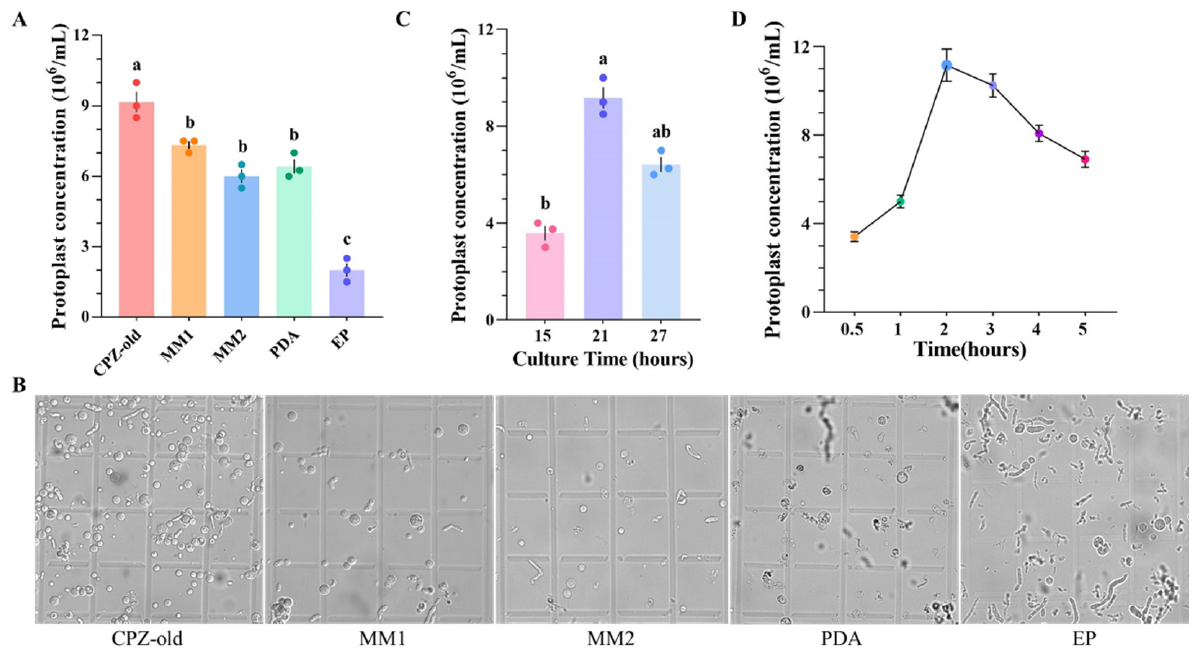
Figure 3. Optimization of protoplast production from A. niger N1 for protoplast-mediated trans- formation (PMT). ( A ) Column diagram of the numbers of protoplast production from A. niger N1 in different media (CPZ-old, MM1, MM2, PDA, and EP). ( B ) The protoplast production in each 4 × 4 square corner area of the hemocytometer for A. niger N1 in different media (CPZ-old, MM1, MM2, PDA, and EP). ( C ) Protoplast production at different culture times (15, 21, and 27 h) of A. niger N1 in CPZ-old medium. ( D ) Protoplast production with different lysing times (0.5, 1, 2, 3, 4, and 5h) of A. niger N1 cultured on CPZ-old medium. Data represent mean ± SD. Means with different lower- case letters (a-c) in each graph differed significantly (Tukey’s HSD, p < 0.05). Error bars: SD of the mean from three repeated assays.. Table 1. Effect of different enzymatic combinations on the release of A. niger N1 protoplasts. Lysing Enzymes Lysing enzymes from T.